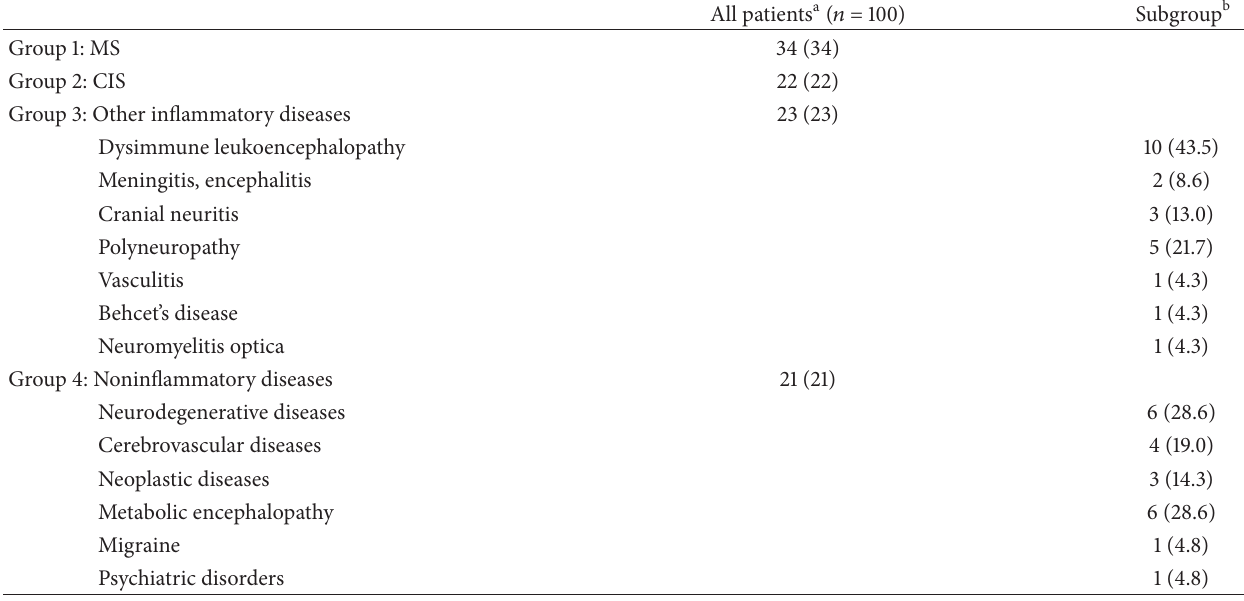
Table 1: Characteristics of the patient